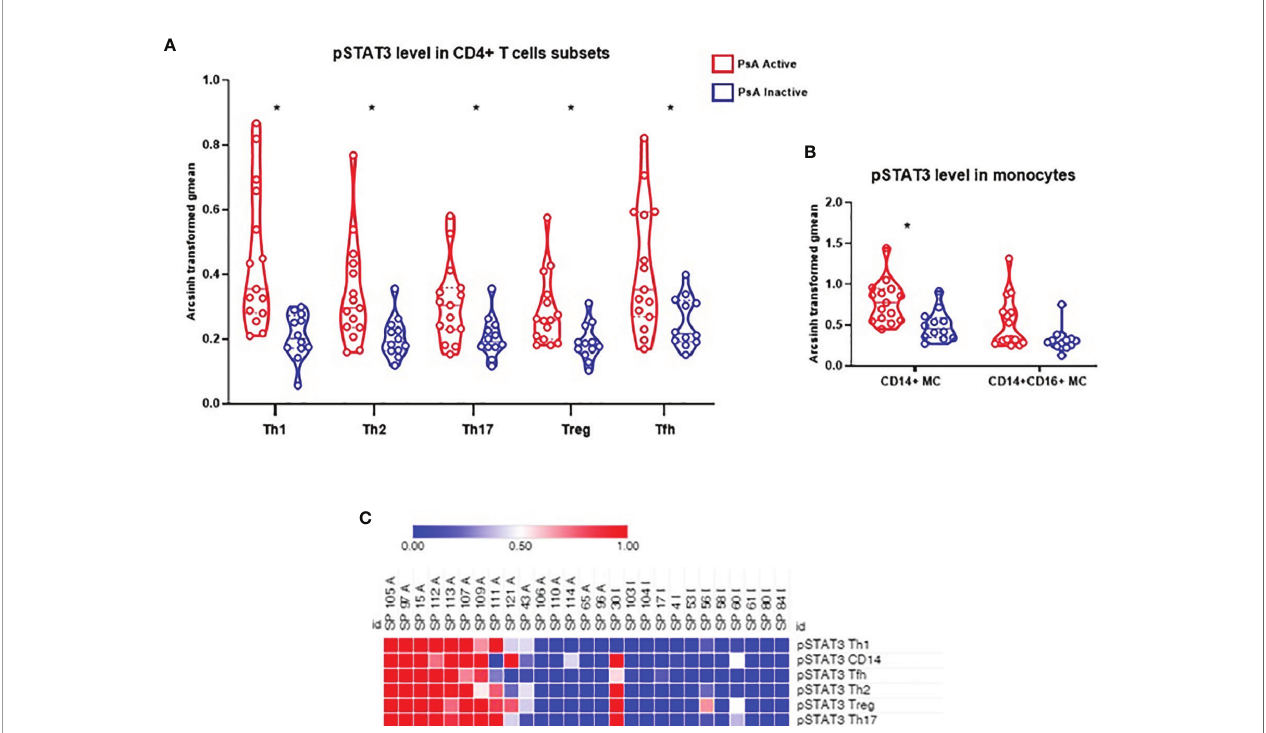
FIGURE 2 | Levels of pSTAT3 are increased in CD4+ T cell subsets and in classical monocytes during active PsA. (A) Signal intensity of pSTAT3 in CD4+ T cell subsets from PsA patients. (B) Signal intensity in monocytes: CD14+CD16- (classical) subset and CD14+CD16+ (Intermediate) subset. Data expressed as arcsinh transformed geometric mean (gmean), displayed as violin plots, with the straight line representing the median and dashed lines the quartiles. Samples from 15 active PsA patients and 12 inactive PsA patients were tested. Group to group comparison using unpaired t test with Welch ’ s correction, all values p<0.05, see Supplementary Tables 2 , 3 for details. *: signi fi cant difference between the 2 groups by two class unpaired SAM analysis, FDR <1% (q<0.01). (C) Heat map showing STAT3 phosphorylation signal in CD4+ T cell subsets and CD14+ (classical) monocytes). A, Active PsA; I, Inactive PsA; Tfh, T follicular helper; MC, Monocytes.